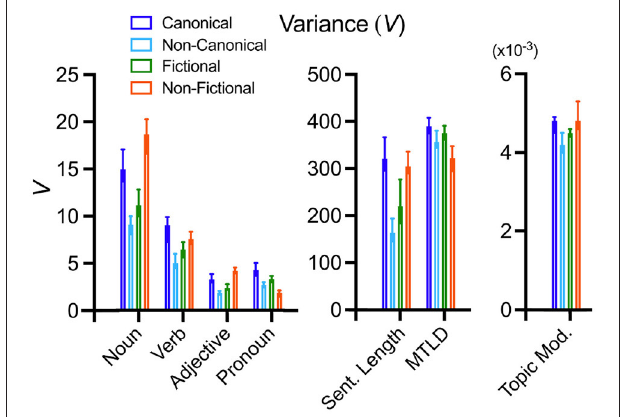
Figure 5C ). For lower-level properties, fictional texts are